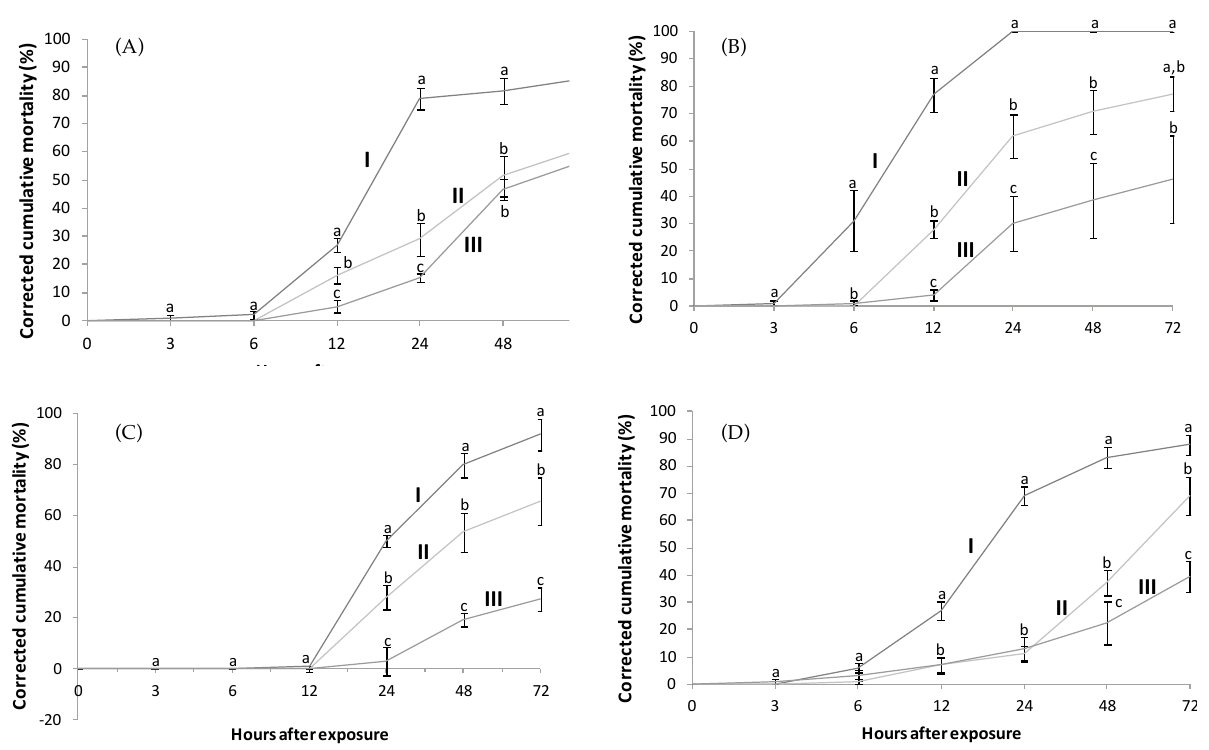
Figure 1. Mean corrected cumulative mortality (%) of Pratylenchus thornei mixed stages exposed to different concentrations of juglone (A) and 1,4-naphthoquinone, alone (B) or combination (2:1 w:w) (C), and plumbagin (D). Treatment concentra- tions are: I, 500 ppm; II, 250 ppm; or III, 150 ppm. Data were corrected with reference to Triton X-100 5,000 ppm, and are means of five replicates. Vertical bars indicate standard errors. Means for each compound accompanied by the same letter do not differ ( P >0.05) according to the Fisher LSD or Kruskal-Wallis